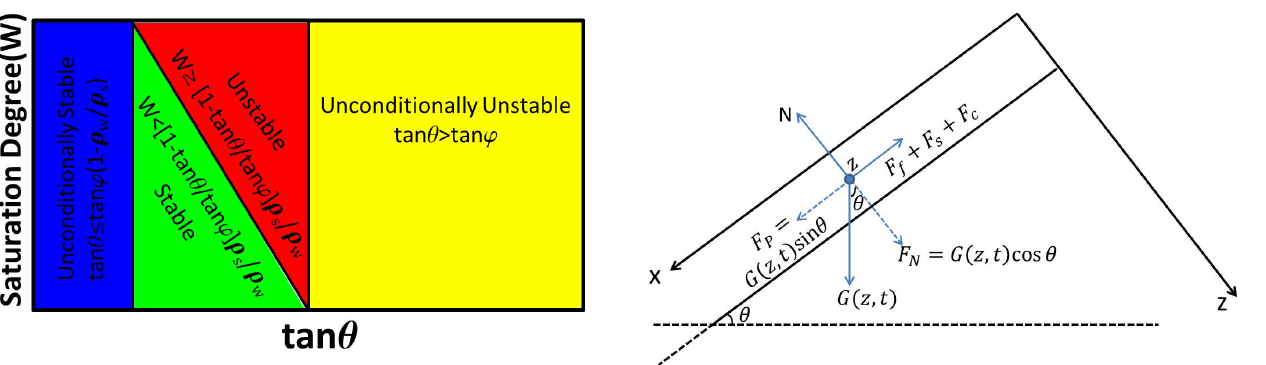
Fig. 3. Conceptual schema of the geotechnical system, explicitly showing the essential forces acted on a